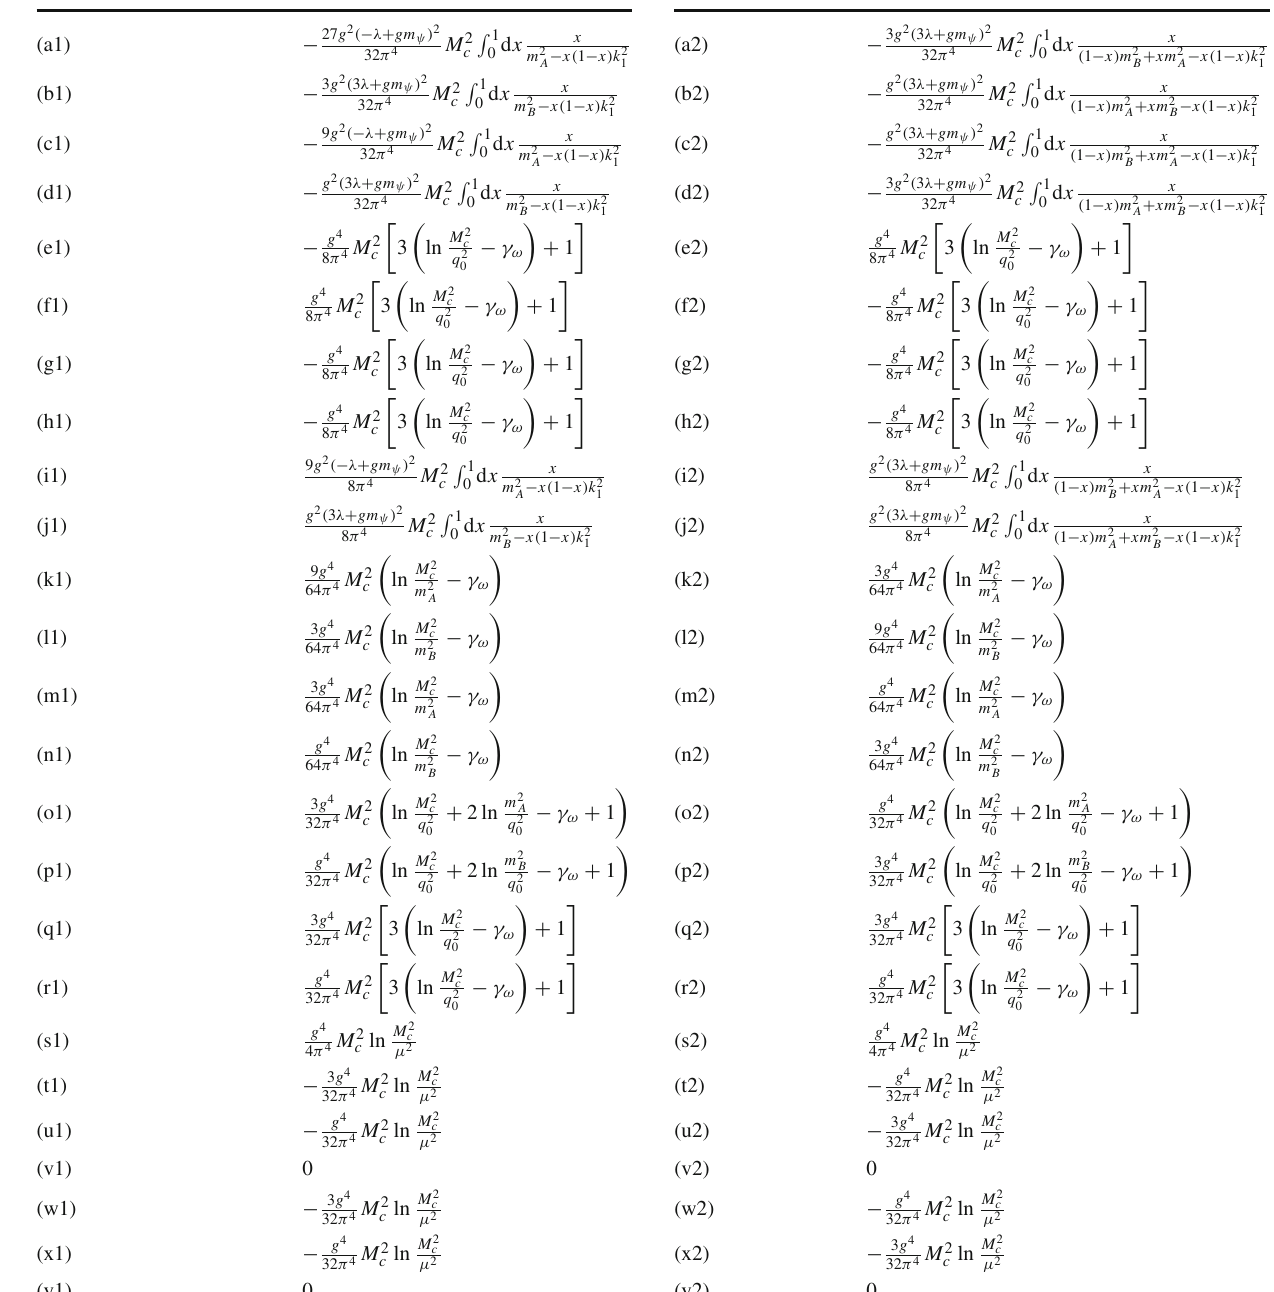
Table 2 Quadratic contributions in the two-loop self-energy diagrams of scalar particle A Diagram Quadratic contributions